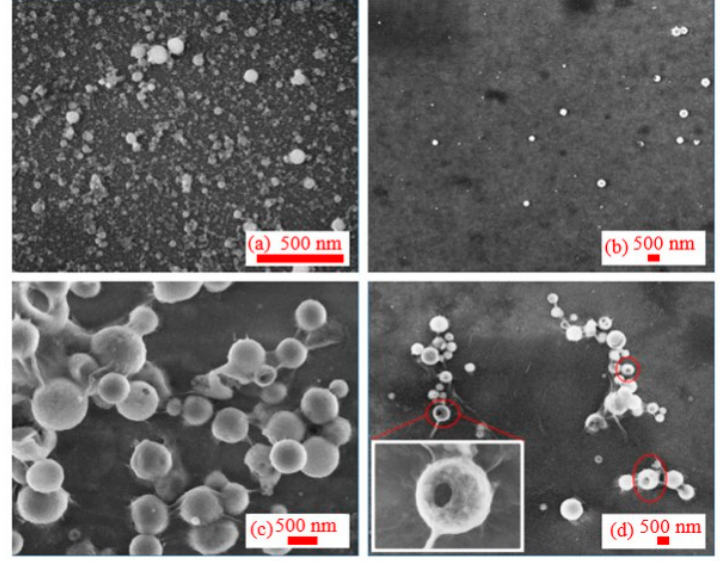
Figure 3. SEM images at different periods after ablation by 355 nm radiation: ( a ) 1 day, ( b ) 20 days, ( c ) 45 days, and ( d ) 60 days after ablation, inner image: individual particles show "red blood cells" structure due to aging.